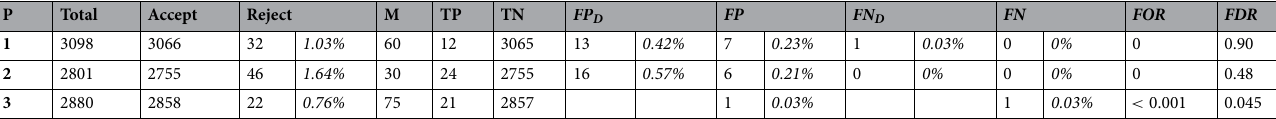
Table 8. Total products considered (Total), accepted products (Accept), rejected products (Reject), test duration in minutes (M), true positives ( TP ), true negatives (TN), false positives of the deterministic procedure ( FP D ), false positives of the CNN model ( FP ), false negatives of the deterministic procedure ( FN D ), false negatives of the CNN model ( FN ), false omission rate ( FOR ) and false discovery rate ( FDR ) for each phase (P) of the real scenario test with the final pre-trained DenseNet161. Percentages have been computed from total